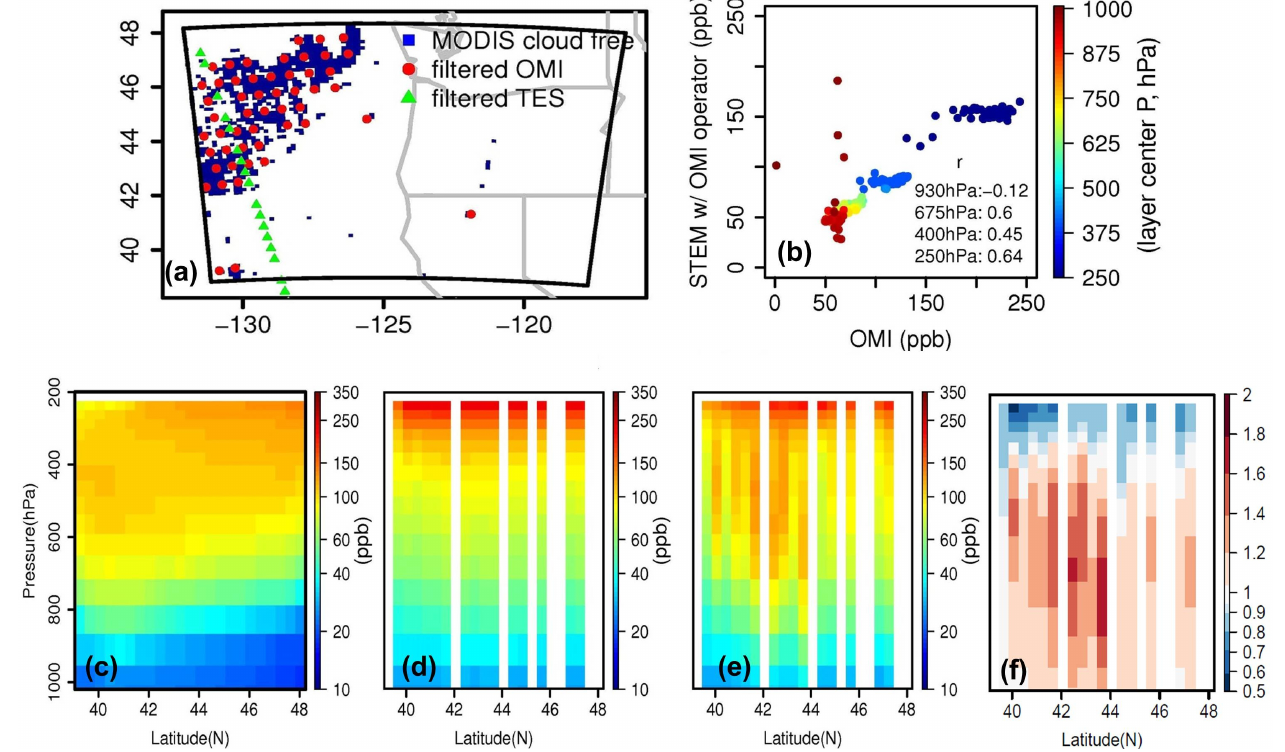
Fig. 11. (a) The data assimilation domain in 12km/32 layer grid and the locations where the selected (based on the criteria described in Table 3) TES and OMI measurements were made. (b) Scatter plot of STEM a priori (with OMI observation operator) vs. OMI retrieval, colored by pressure at OMI layer centers (hPa). (c) STEM a priori (raw data) along the TES orbit at the overpass time, interpolated into the TES pressure levels; (d) STEM a priori (with TES observation operator) along the TES orbit; (e) TES O 3 nadir retrieval; (f) the ratios of (e) / (d) . Table 5. The “IP” metric for three locations, at all local day times during 16 June–14 July